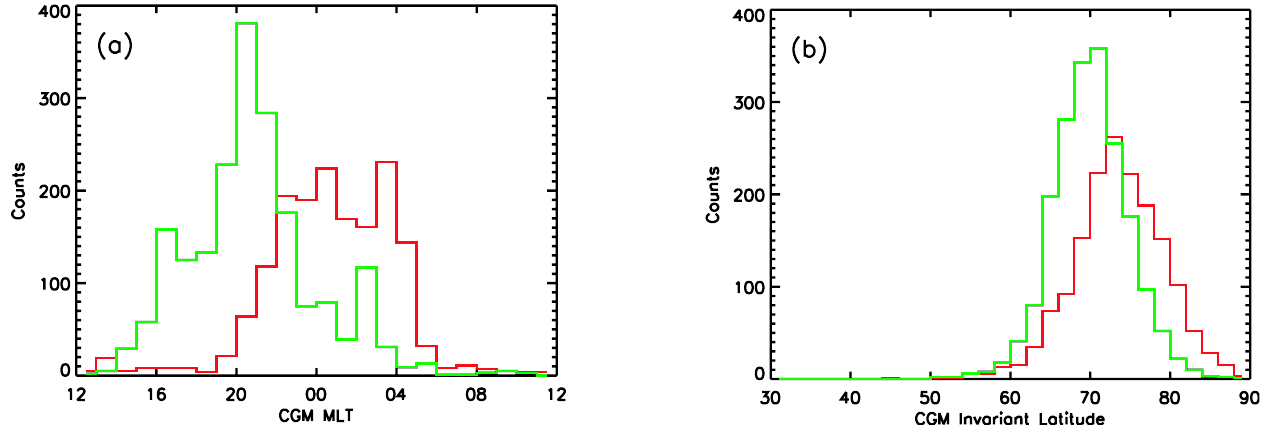
Fig. 7. (a) Histogram of the magnetic local time distribution of AKR burst locations in Northern Hemisphere (1955bursts, green line) and Southern Hemisphere (1644bursts, red line). (b) Same as (a), but for invariant magnetic latitude.